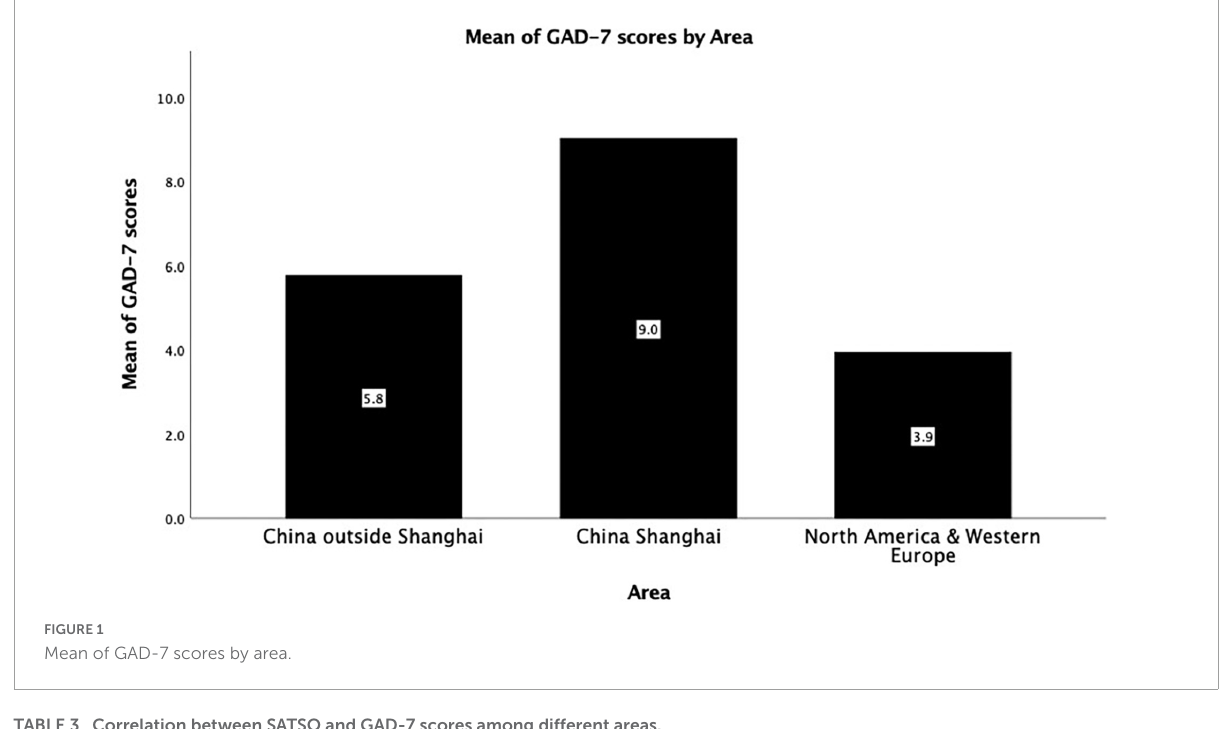
TABLE 3 Correlation between SATSO and GAD-7 scores among different